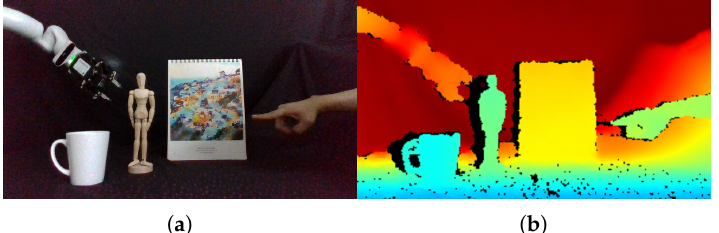
Figure 1. An example of 3D human–robot interaction. ( a ) The RGB image lacks 3D information, and it is difficult to distinguish which object the hand refers to. ( b ) The depth image encodes the distances from objects to the camera. It is easy to infer that the hand refers to the wooden puppet according to the depth image.